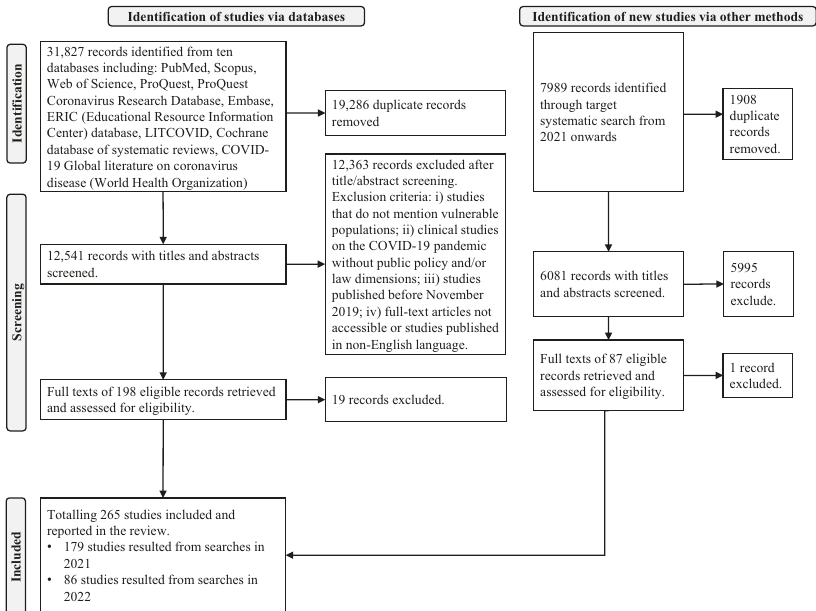
Fig. 1 | Preferred Reporting Items for Systematic Reviews (PRISMA) fl ow diagram. It summarises the data collection and screening processes. We screened 39,816 records and synthesised 265 eligible studies in this